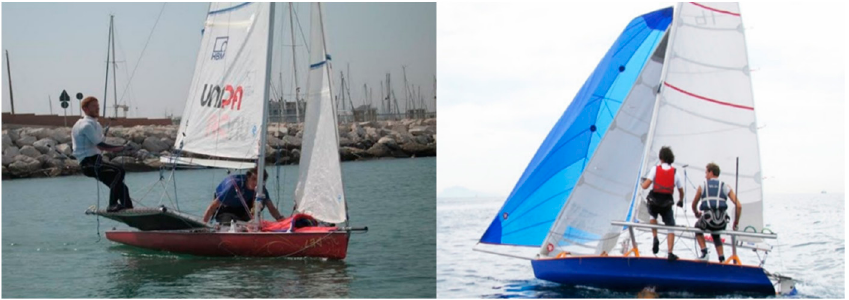
Figure 14. The Sail Keep It Flat and Fast (SKIFF) LED and TryAgain during the regattas of 2013 in La Spezia, Italy.